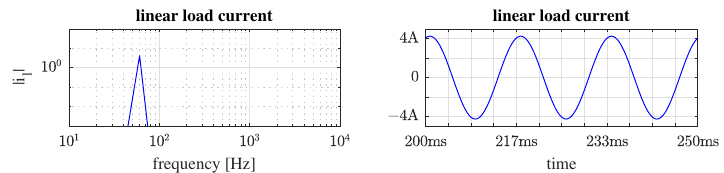
Figure 14. Linear load current: FFT results and